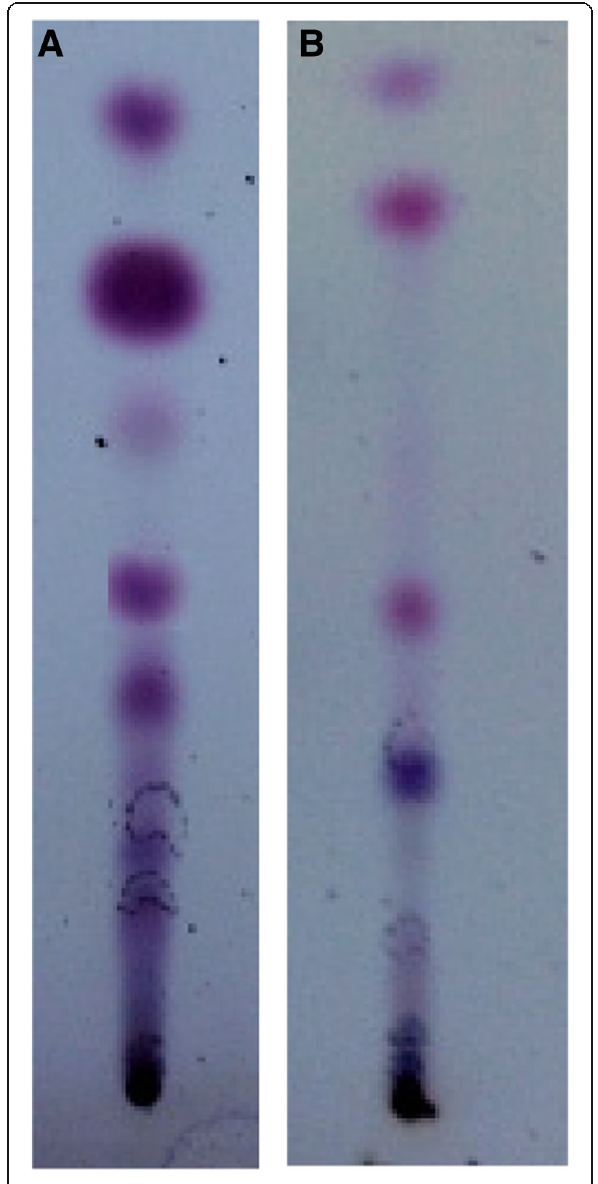
Table 4 Anti-fungal activity of different extracts of F.